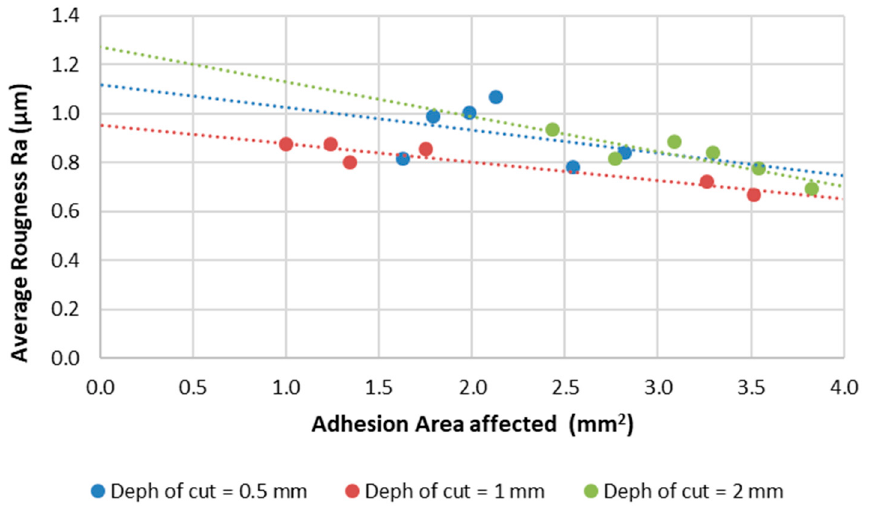
Figure 14. Evolution of Ra as a function of the area affected by adhesion, for each depth of cut. Dotted lines represent linear trends.